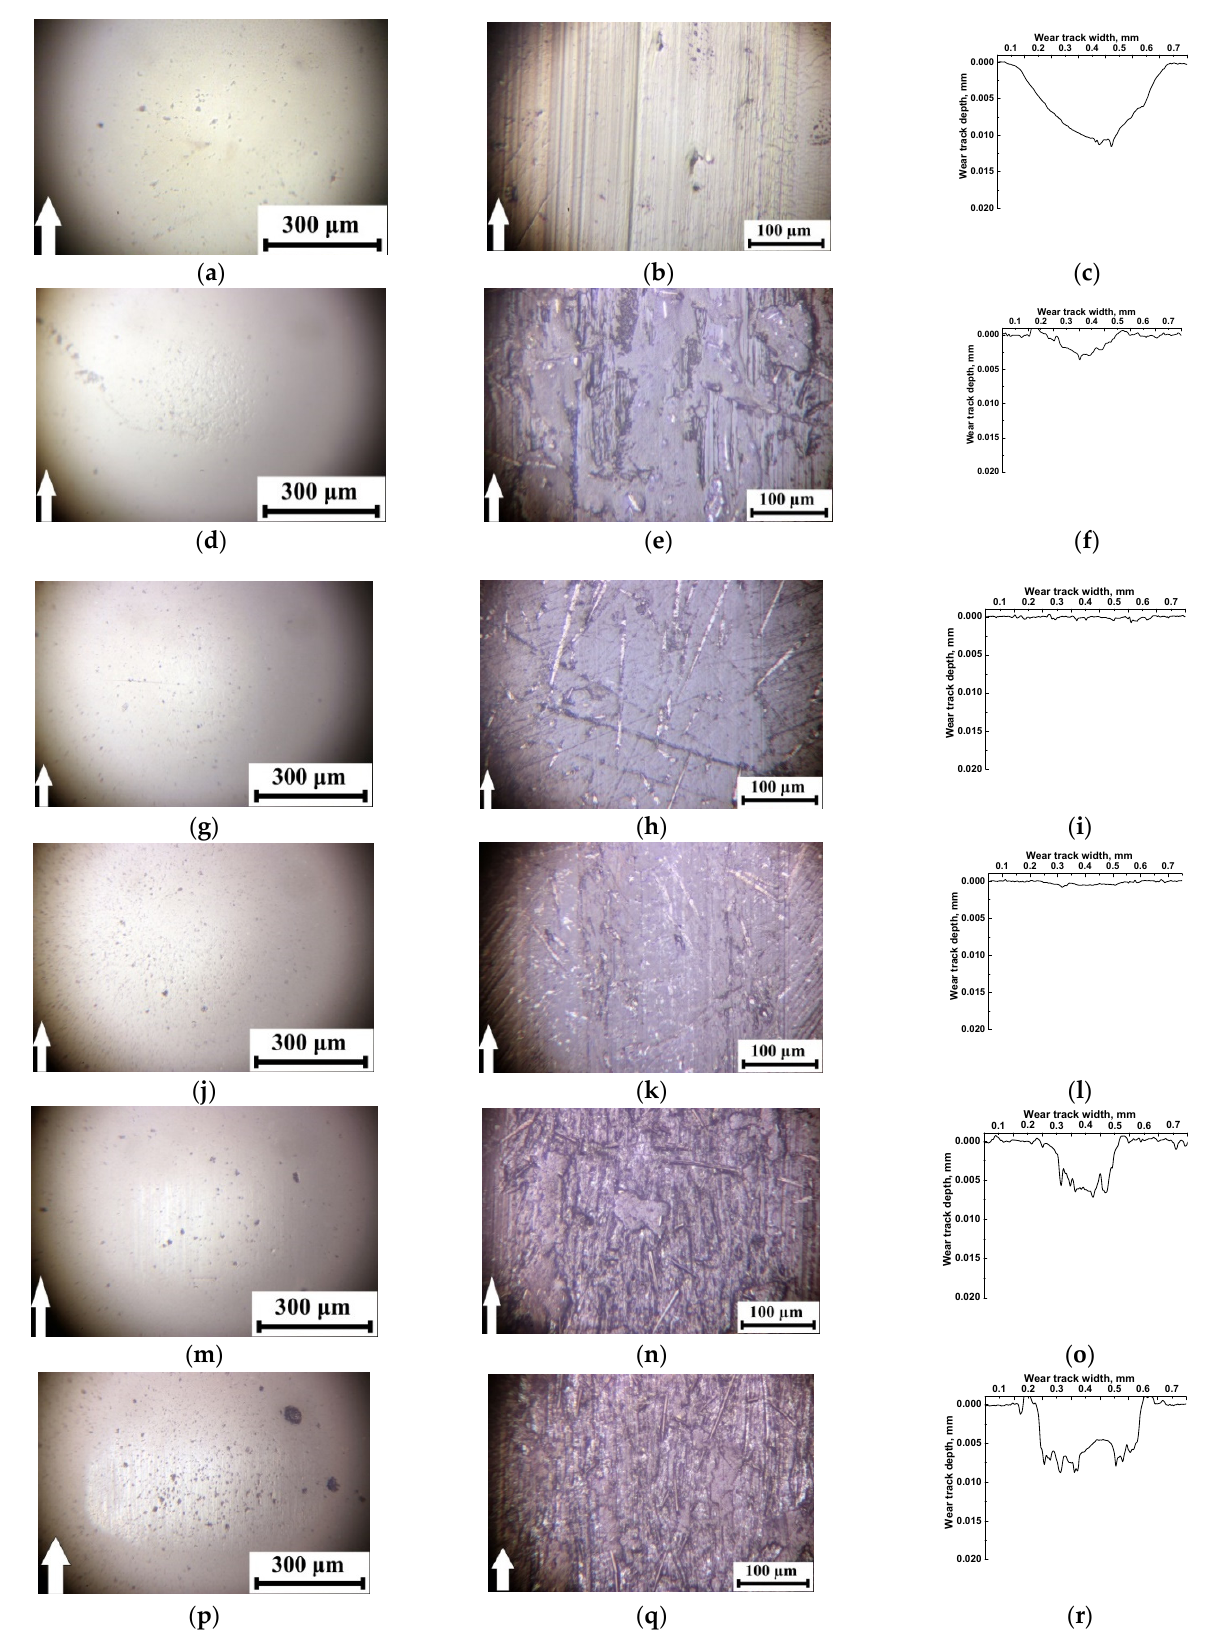
Figure 7. The optical images of the friction surfaces on the ceramic counterpart and neat PI ( a – c ), as well as the PI/10CCF ( d – f ), PI/10CCF/10PTFE ( g – i) , PI/10CCF/10Gr ( j – l ), PI/10CCF/10MoS 2 ( m – o ), and PI/10CCF/23MoS 2 ( p – r ) composites.